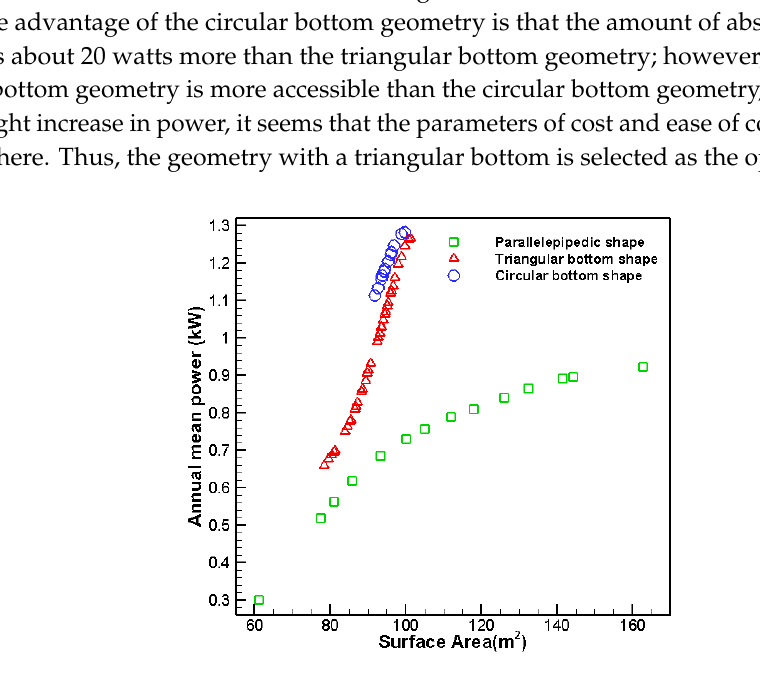
Figure 16. Pareto fronts comparison of the three geometries.